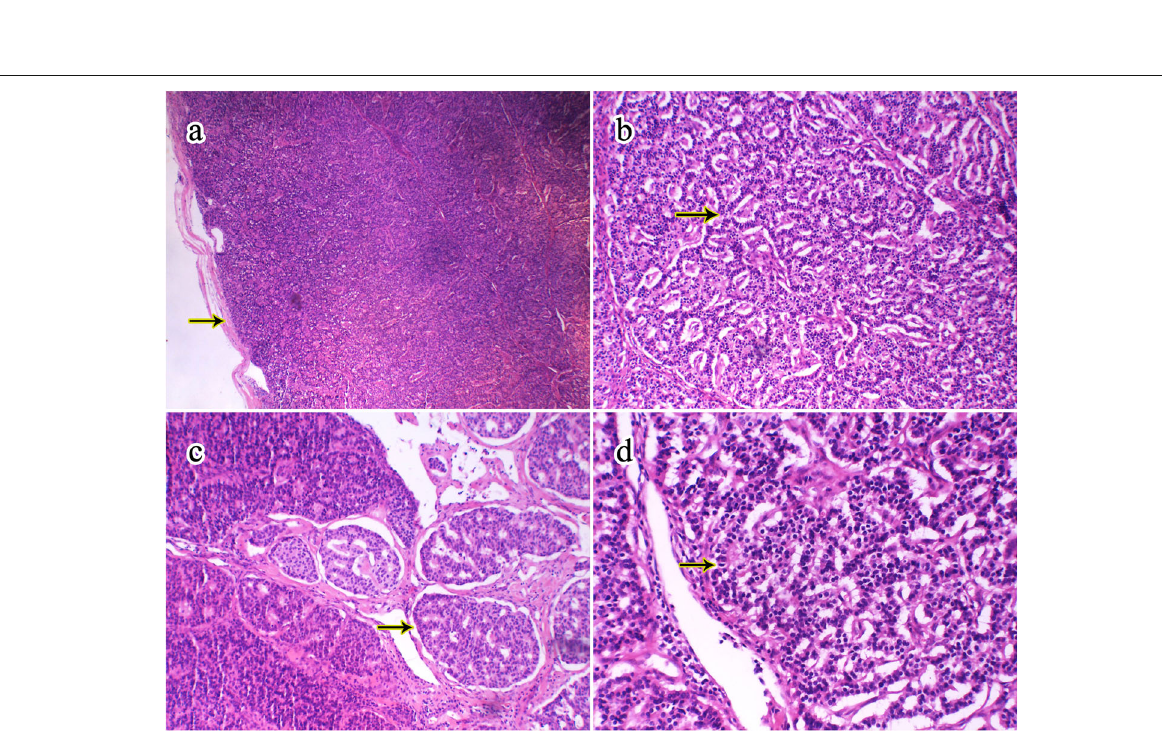
Fig. 2 The image of HE. a showed a complete capsule of the mass (40×, the arrow); b demonstrated tumor cells arranged with pseudo-glandular (the arrow), c presented sieve-like patterns in tumor cells (100×). d The round cells were well-differentiated (200×)